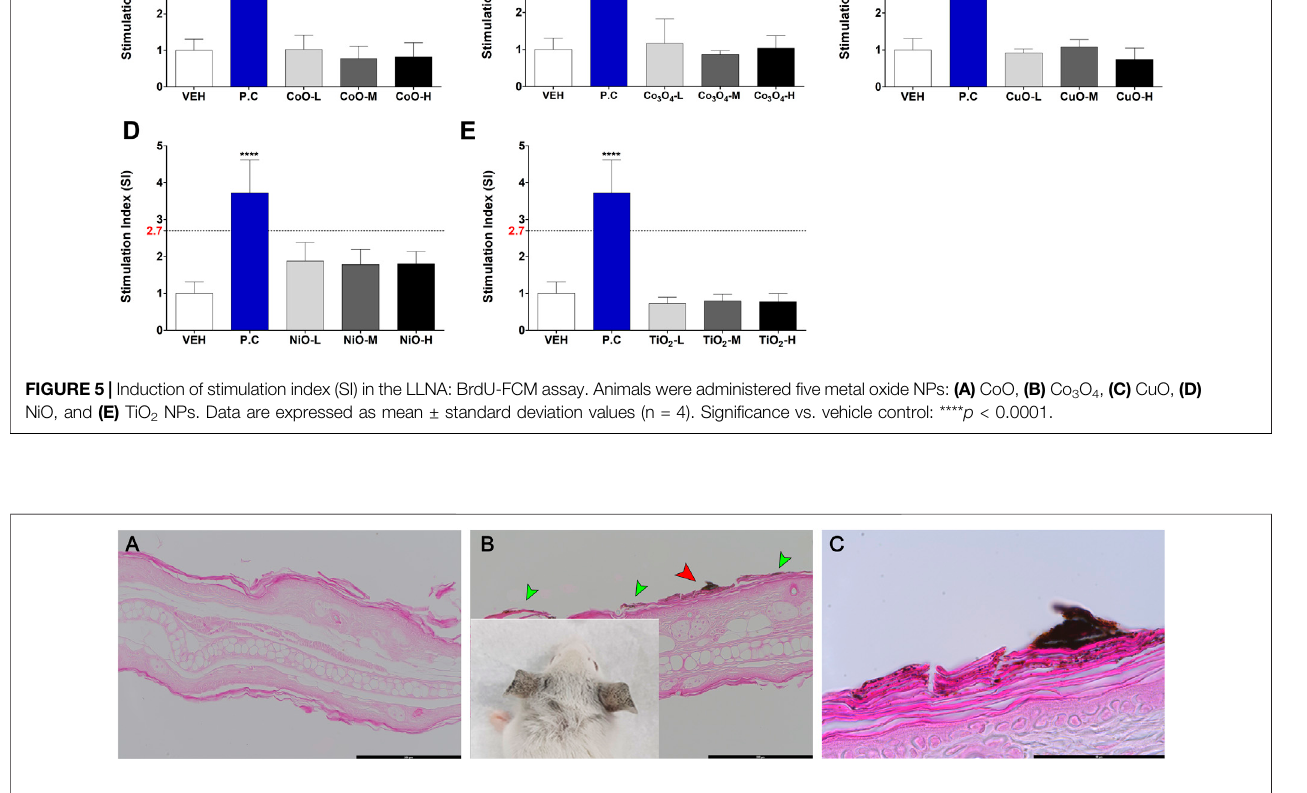
FIGURE 6 | Histologic examination of eosin-stained ear skin tissue after exposure of mice to copper oxide NPs. (A) Vehicle control (DMF), (B) and (C) treated with CuO NPs. CuO NPs accumulated in the stratum corneum (green arrow). (C) is a high-magni fi cation image of the red arrow portion in (B) . Scale bars: (A) 200 μ m, (B) 200 μ m, (C) 50